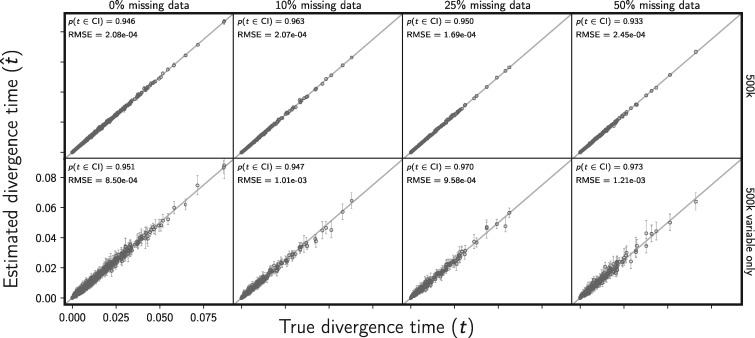
Assessing the effect of missing data on the accuracy and precision of divergence time estimates (in units of expected subsitutions per site). The columns, from left to right, show the results when each simulated 500,000-character matrix has approximately 0%, 10%, 25%, and 50% missing cells. For comparison, the first column shows the results of the 500 data sets from Figure 2; the remaining columns show the results of 100 data sets. The rows show the results when (top) all sites and (bottom) only variable sites are analyzed. For each plot, the root mean square error (RMSE) and the proportion of estimates for which the 95% credible interval contained the true value—\documentclass[12pt]{minimal}
\usepackage{amsmath}
\usepackage{wasysym}
\usepackage{amsfonts}
\usepackage{amssymb}
\usepackage{amsbsy}
\usepackage{upgreek}
\usepackage{mathrsfs}
\setlength{\oddsidemargin}{-69pt}
\begin{document}
}{}$p({{t}}\in \textrm{CI})$\end{document}—is given. All simulated data sets had three pairs of populations. We generated the plot using matplotlib Version 2.0.0 (Hunter 2007)